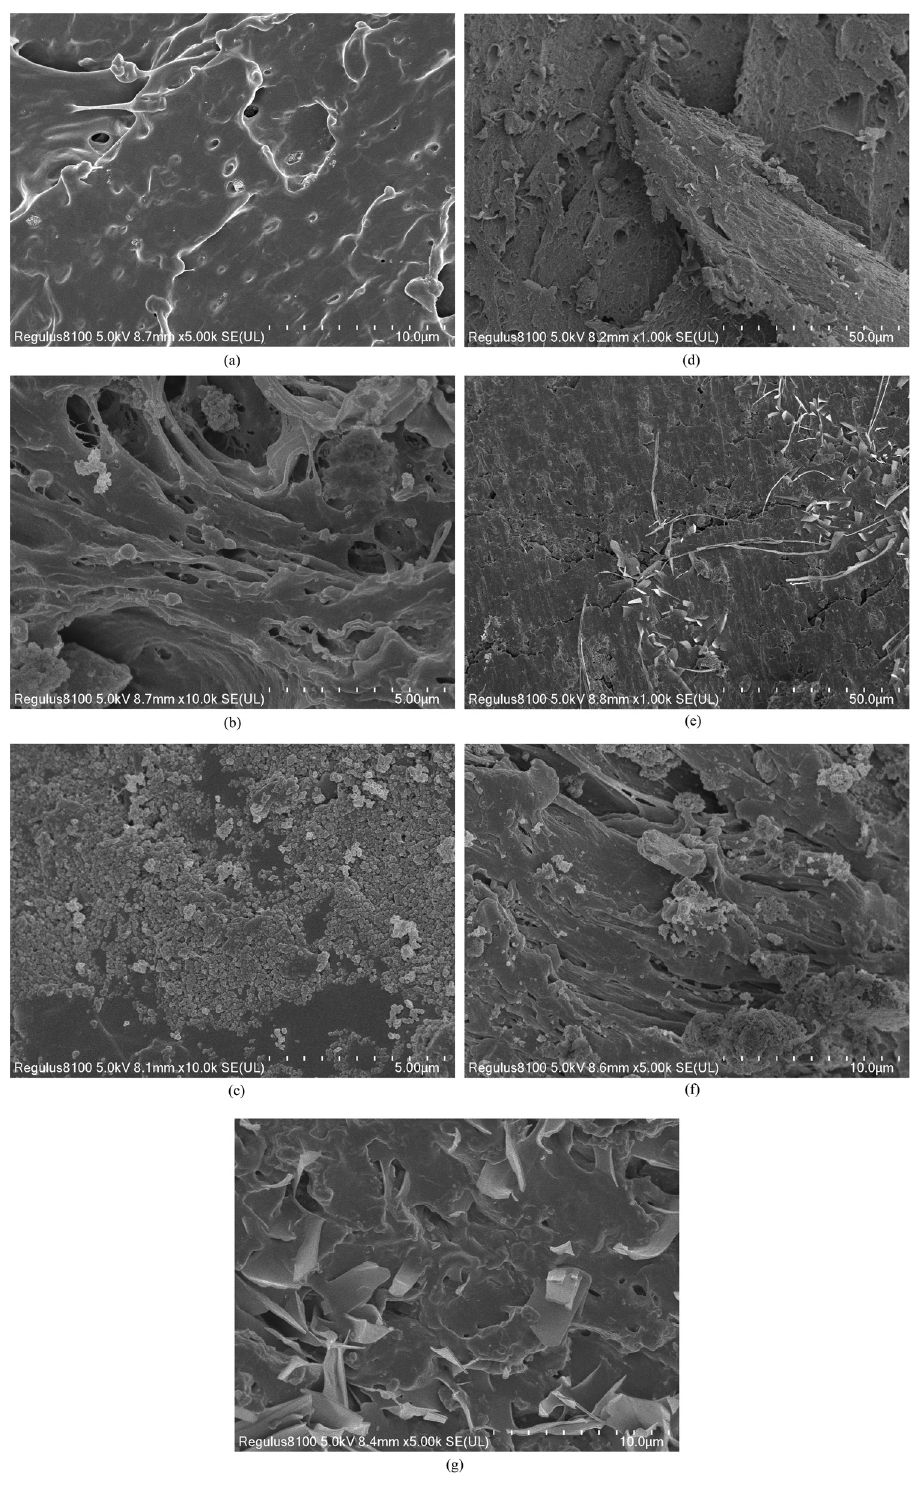
Figure 7: SEM images of the impact - fractured surfaces of PLA/PBAT/CaCO 3 composites: ( a ) 90 L 10 B, ( b ) 90 L 10 B 5n Ca, ( c ) 90 L 10 B 10n